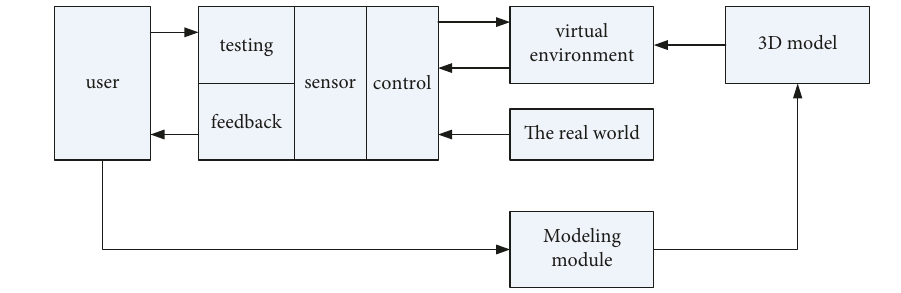
Figure 1: Virtual reality technology modeling process.